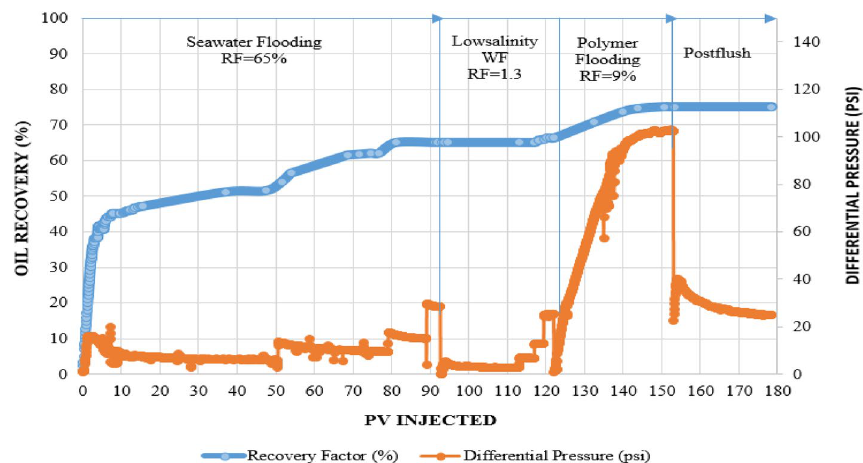
Fig. 13 Oil recovery factor and differential pressure vs PV injected during oil recovery of